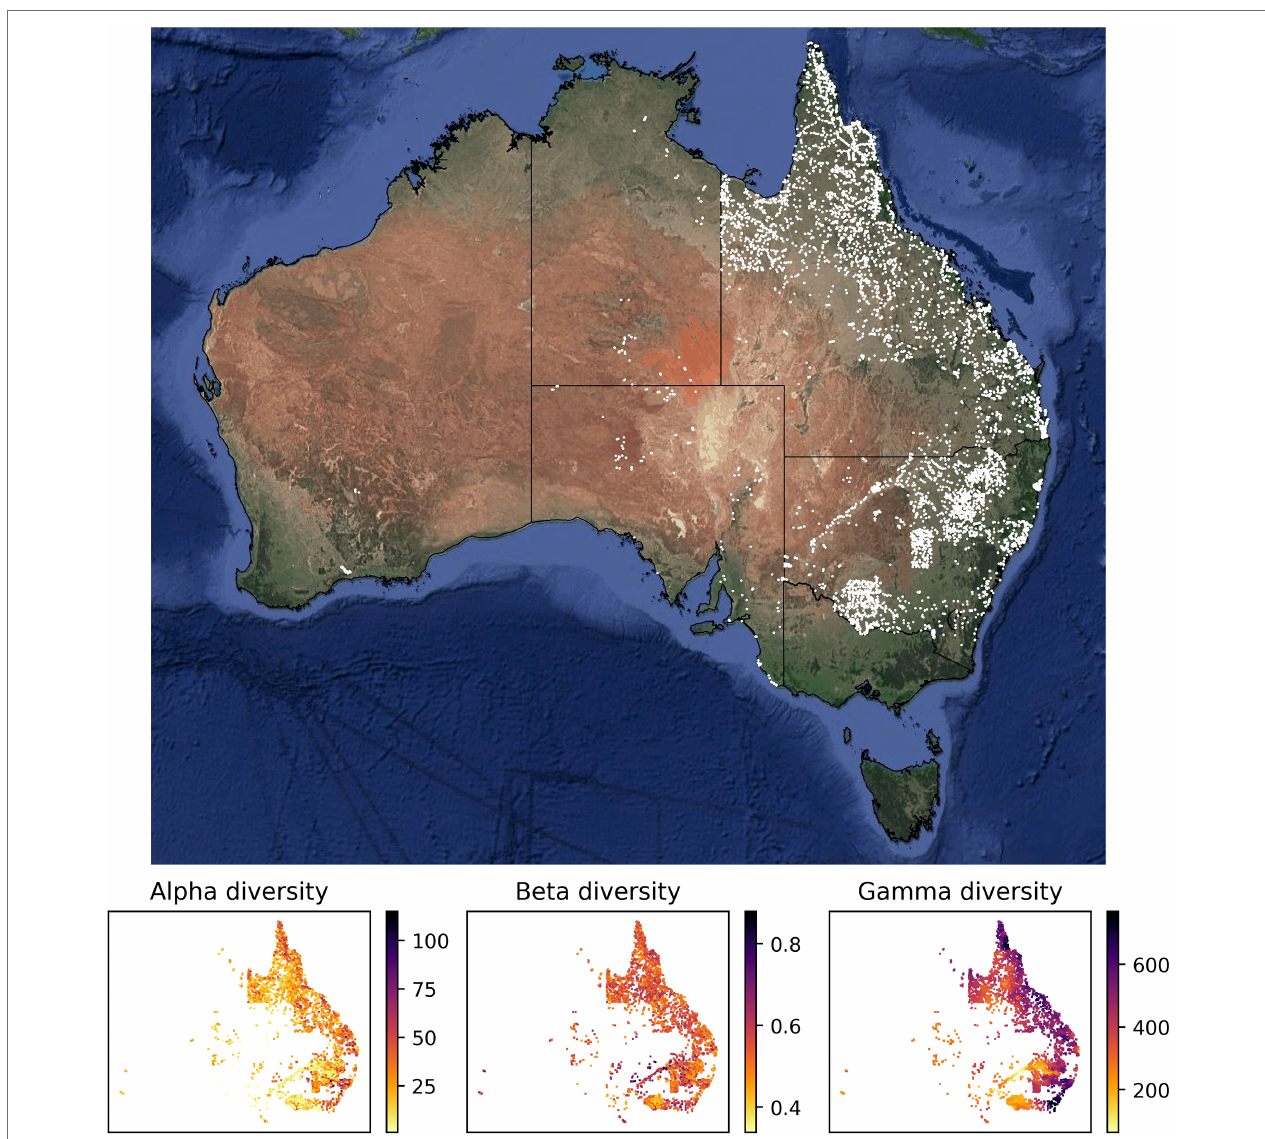
FIGURE 1 | Sites with vegetation plot data used in this study for model training and evaluation. Most of the vegetation plot sites used in this study (white points, 7,896 sites) are located in the easternmost two Australian states Queensland (northeast) and New South Wales (center east). The panels below the map show the compiled measures of alpha, beta, and gamma diversity for all vegetation plot sites. The satellite image of Australia was downloaded via ggmap (Kahle and Wickham, 2013). The spatial scale of the alpha diversity estimates is defined by the plot size of the underlying vegetation plots and differs among sites. Similarly, the gamma diversity values are based on sets of 50 neighboring vegetation plots; depending on the spatial density of vegetation plots, these diversity values are therefore determined across different spatial scales. Both values, the size of the vegetation plot and the spatial scale of each gamma diversity estimate, are used as features in our